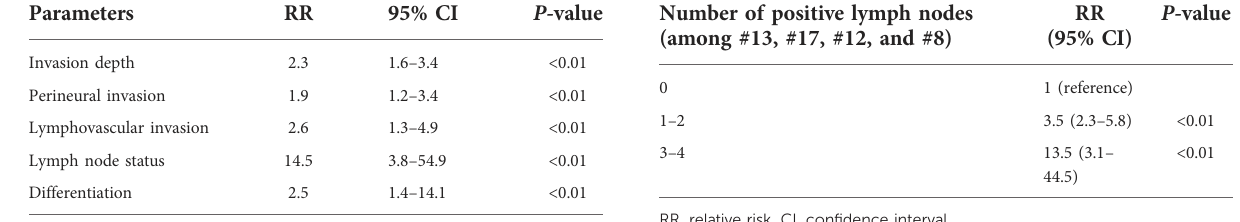
TABLE 5 Multivariate analysis of variables on survival of ampullary adenocarcinoma patients.